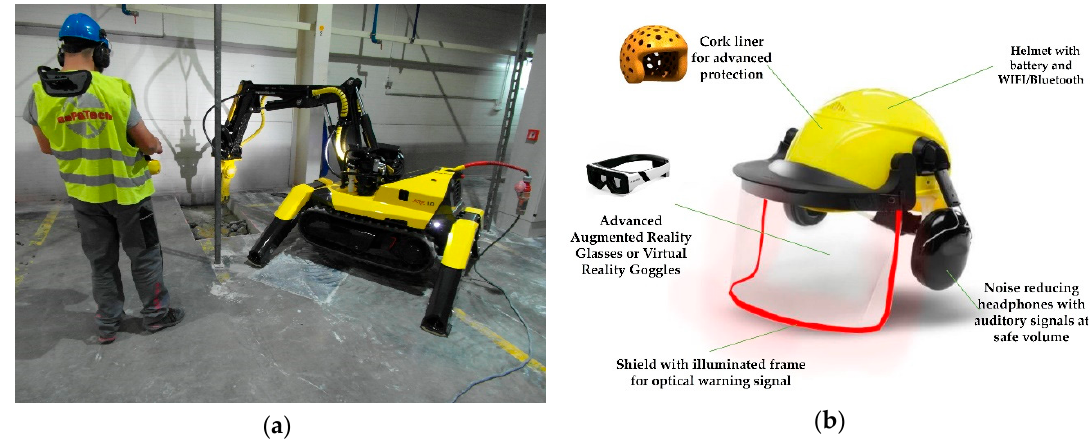
Figure 14. Use of safety helmets: ( a ) operator with safety equipment—helmet; ( b ) Concept of a combination between a helmet and a HMI with advanced features adapted from [4,32–35].